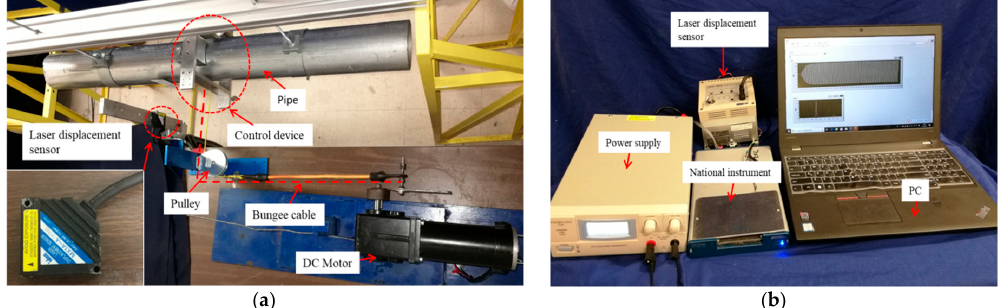
Figure 6. ( a ) Experimental setup and ( b ) data acquisition system.